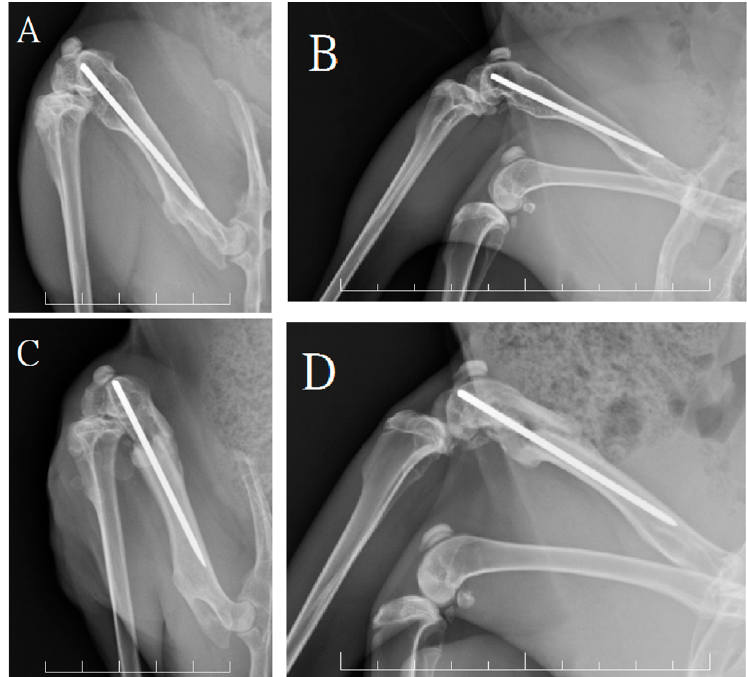
Figure 3. The radiographic assessments at 24 weeks. The anterioposterior ( A ) and lateral ( B ) view of a rabbit in group A showed good bone growth within the bone defect site with intact anterior cortical integrity; The anterioposterior ( C ) and lateral ( D ) view of a rabbit in group B showed callus formation but had broken of the anterior cortex. Each frame rates one centimeter.